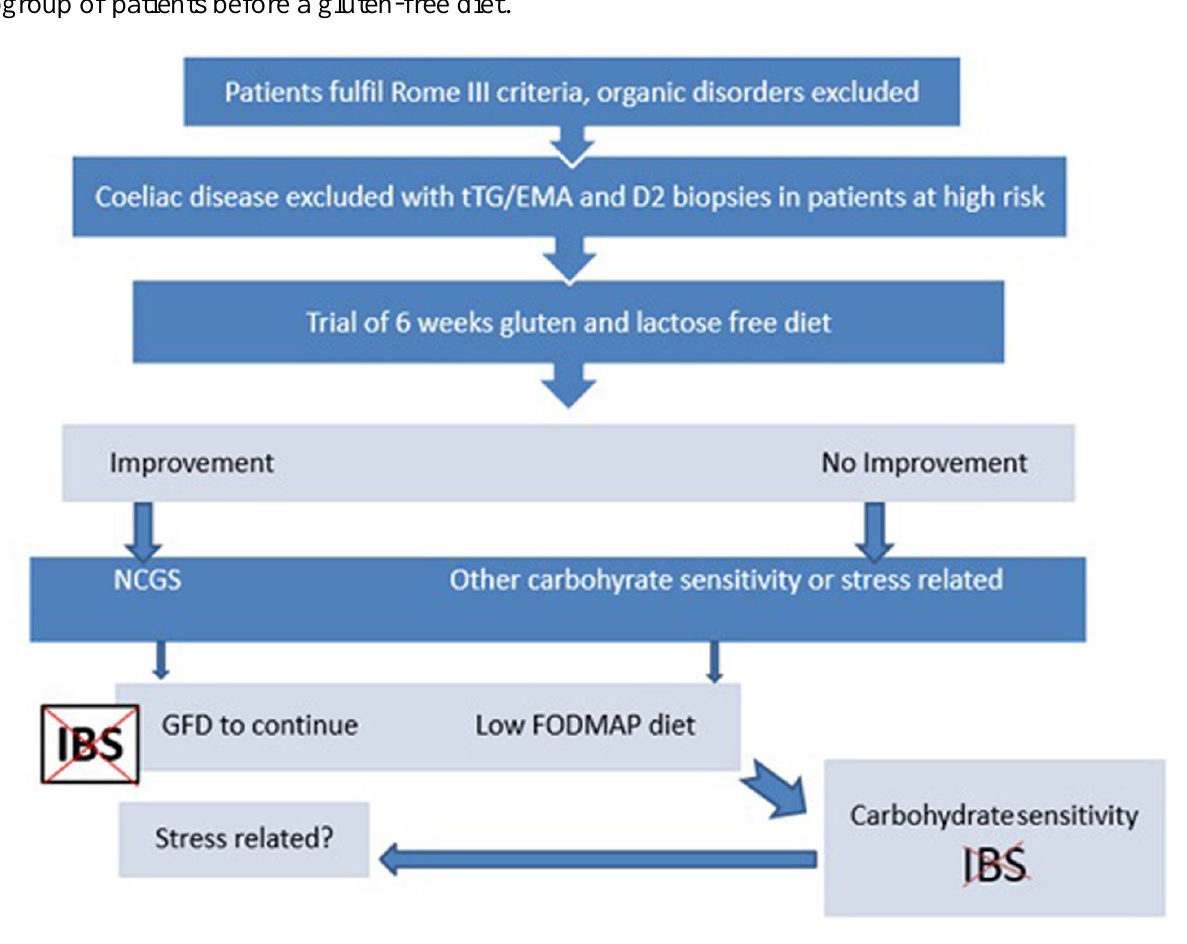
Figure 3. Suggesting